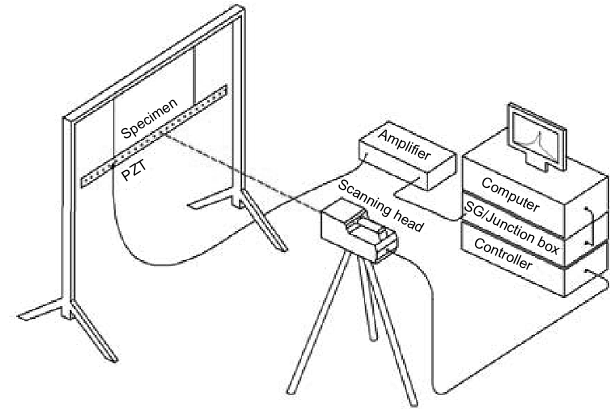
Fig. 2. Scheme of experimental